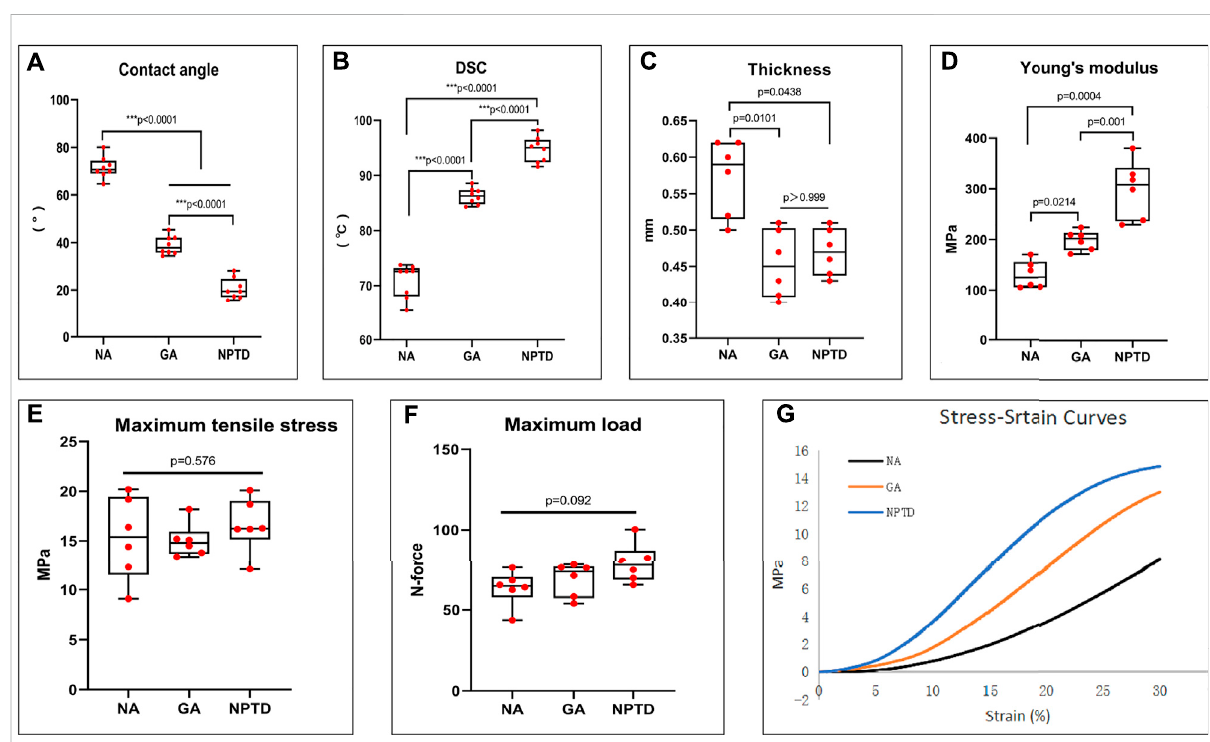
FIGURE 4 The water contact angle, thermal denaturation temperature (Td) and biomechanical properties of the bovine pericardium. The water contact angle of the lea fl ets decreased signi fi cantly after NPTD crosslinked compared with those of the NA and GA groups (A) . Td of the NPTD samples was distinctlyimprovedcomparedtothoseoftheNAandGAsamples (B) .Thethinnessofthelea fl etsdecreasedafterNPTDcrosslinkedandwerecloseto those of theGA group (C) . The Young ’ s modulus was signi fi cantly improved inthe NPTD group comparedwith the GAgroup (D) . The Maximun Tensile Stress and Maximum Load among the three groups was no signi fi cant difference (E,F) . The representative stress/strain curves of the groups (G) . Statistical analysis was performed by Kruskal – Wallis test with Tukey ’ s post hoc